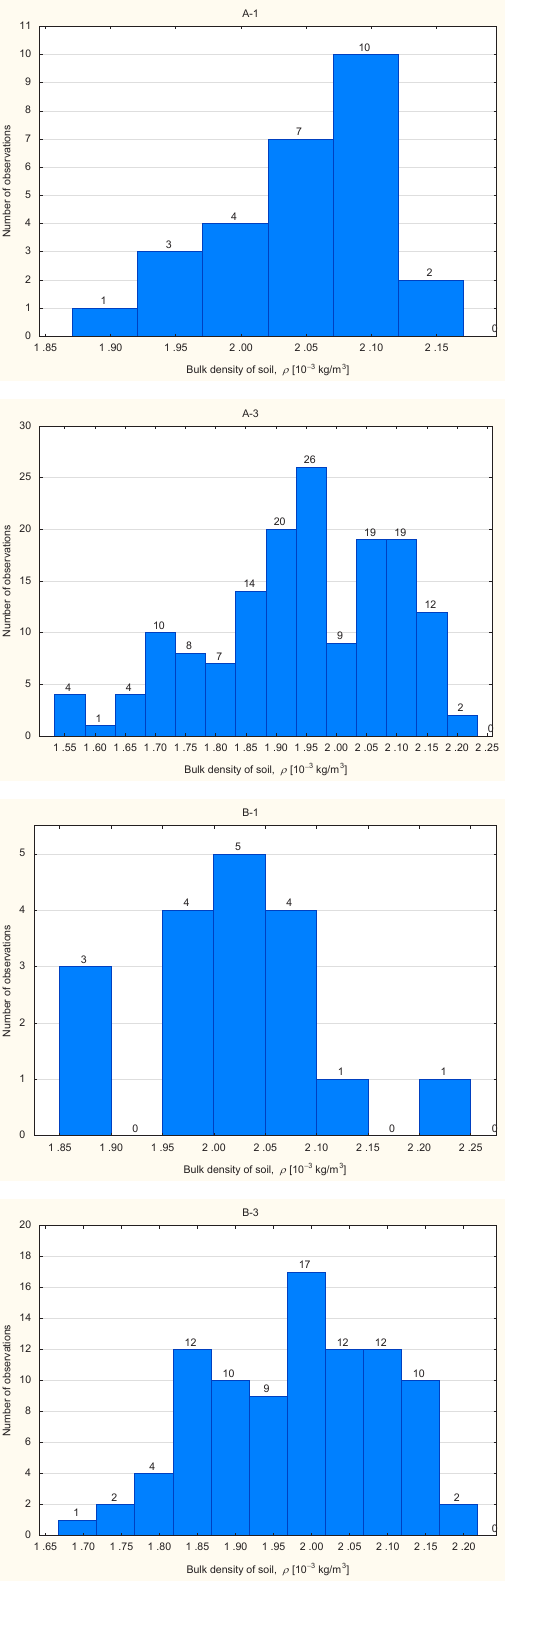
Figure 5: Histograms of bulk density distribution of the dump soil in particular